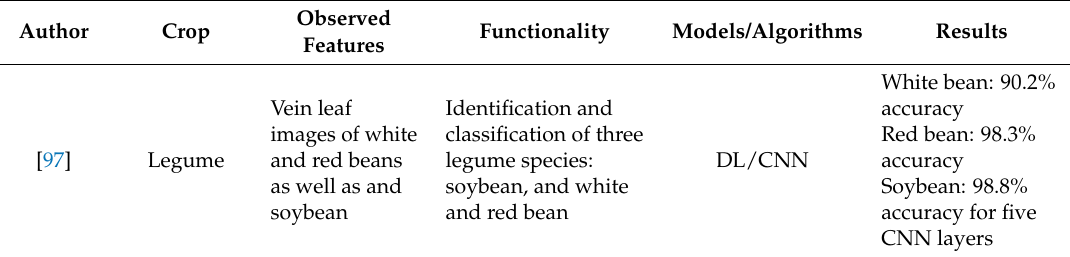
Table 9. Crop: Species